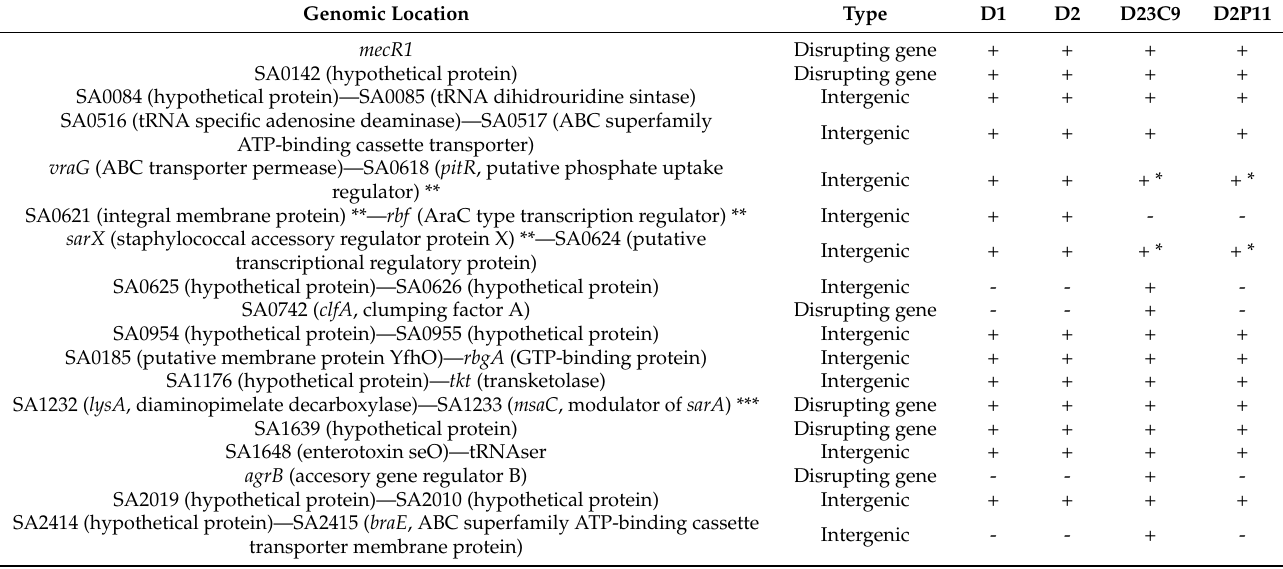
Table 7. IS 256 insertion sites detected with ISseeker software after annotating IS 256 flaking regions against the S. aureus N315 reference genome. Type was considered “intergenic” if IS 256 was found between two different genes, and “disrupting gene” if both annotated flanking regions were found in a single (same)